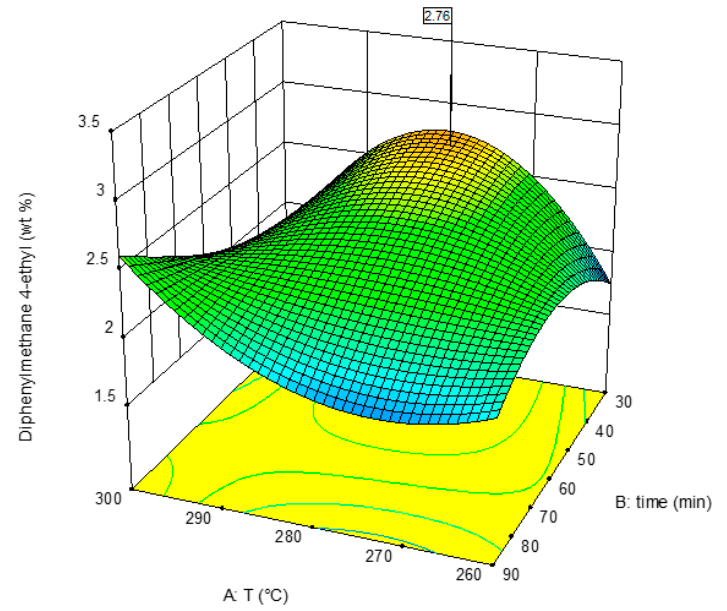
Figure 5. Prediction of the diphenylmethane production at different conditions of temperature and residence time.